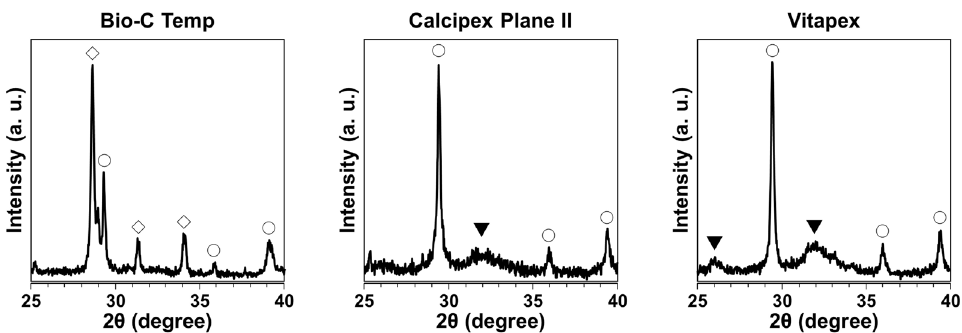
Figure 3. XRD patterns of the precipitates formed on the Bio-C Temp, Calcipex Plane II, and Vitapex implants. ▼ : hydroxyapatite, Ȇ : calcite, ◇ : calcium tungstate.